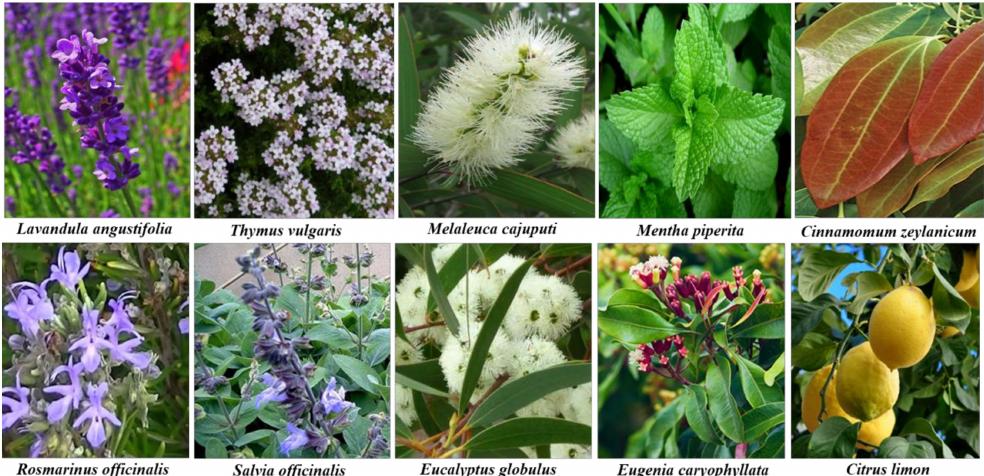
Figure 1. Widely used medicinal plants with high antimicrobial activities against human